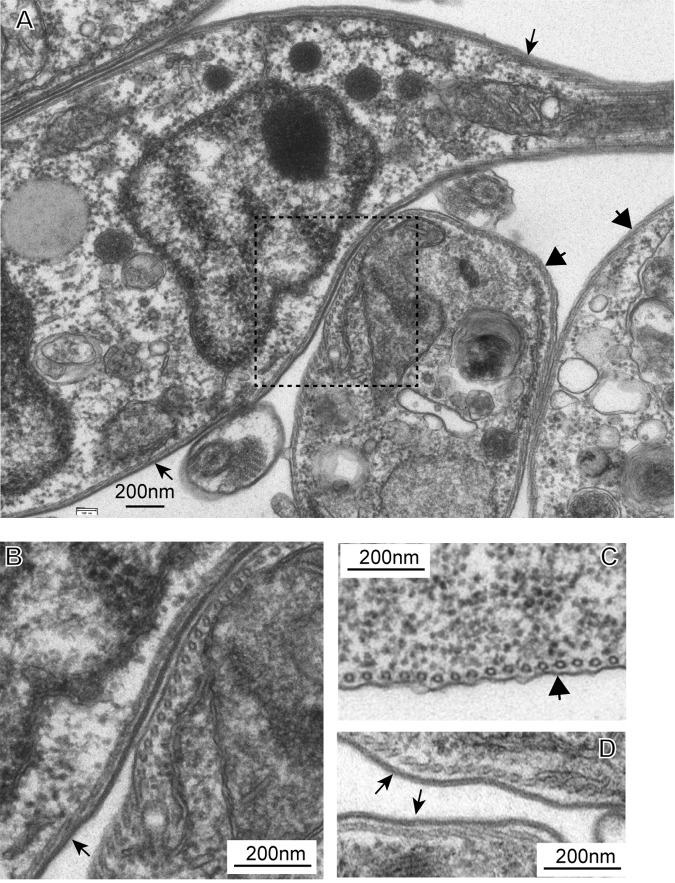
VSG expression after RBP10 induction in procyclic forms: Electron microscopy.A) A sample field from procyclic-form cultures after 48h induced expression of RBP10. The thin arrows point to VSG coats and the thick ones to procyclic surfaces. B) Close-up of the boxed area in (A). C) Typical field showing the surface of a procyclic form. D) Typical field showing the surfaces of bloodstream forms.